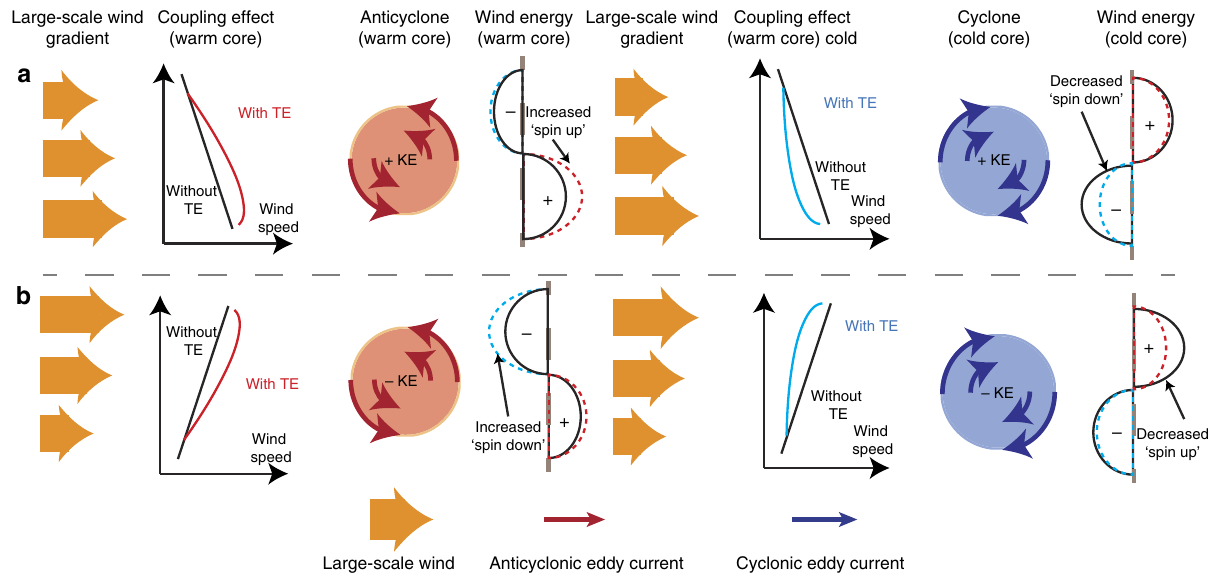
Figure 1 | Proposed modification of the exchange of wind energy between the atmosphere and ocean. ( a ) Cases for a negative wind gradient (increasing from north to south). ( b ) Cases for a positive wind gradient. TE, thermodynamic effect. ( a ) Response for a warm-core anticyclonic eddy and for a cold-core cyclonic eddy separately (both in the southern hemisphere). The eddy-associated anomalies in SST modify the overlying winds and hence the wind stress exerted onto the ocean (coupling effect). In the case of a warm-core eddy lying within a negative wind gradient ( a ), this enhances the energy transfer induced by the mechanical coupling between the eddy current and the wind on the south side of the eddy, whereas it affects the mechanical spin down on the northern side little (wind energy). The net effect is thus an increase in the net energy transfer into the ocean. The other cases operate analogously, resulting in regions with a negative wind gradient tending to energize the oceanic eddies ( a ), whereas regions with a positive gradient having the opposite effect ( b